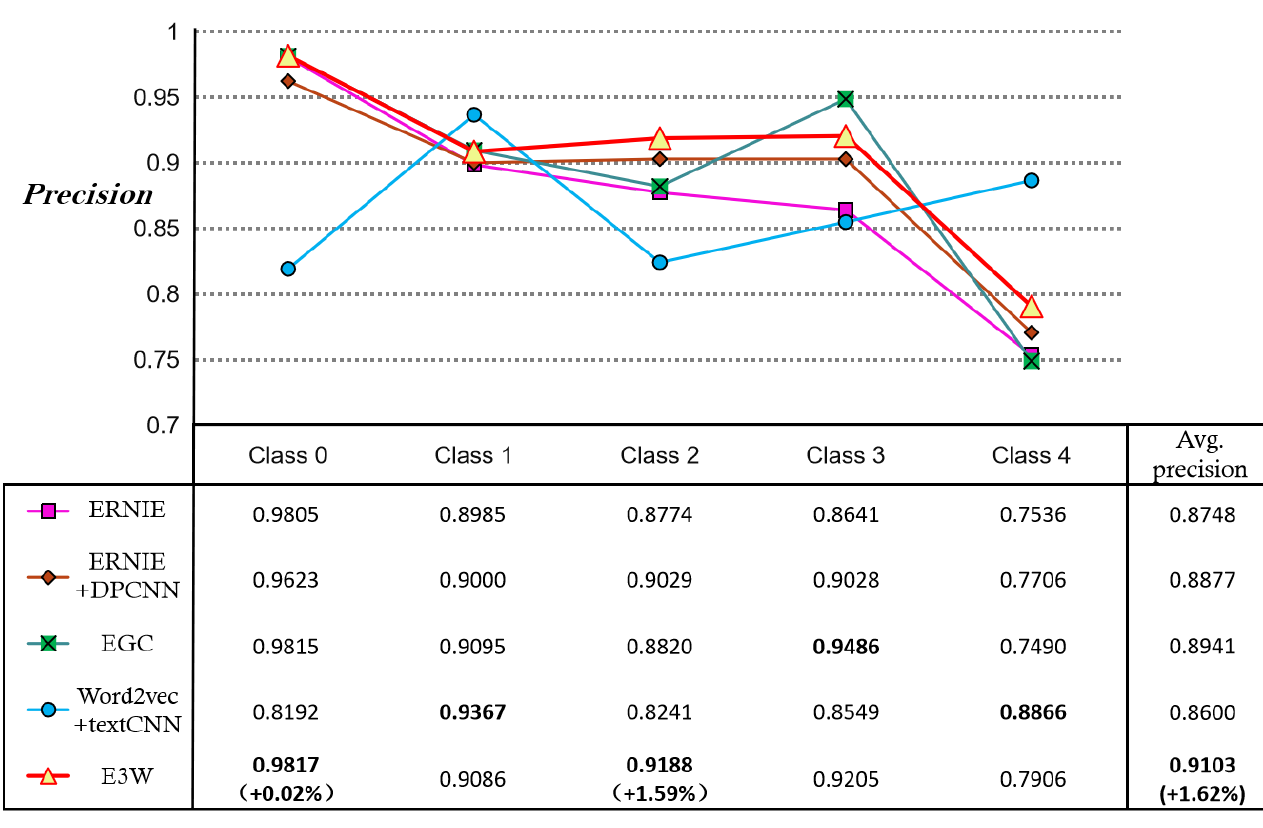
Figure 14. Comparison of precision for E3W and the four sub-models, with the best experimental results in bold and the number in brackets representing the comparison of the current model with the previous best model.